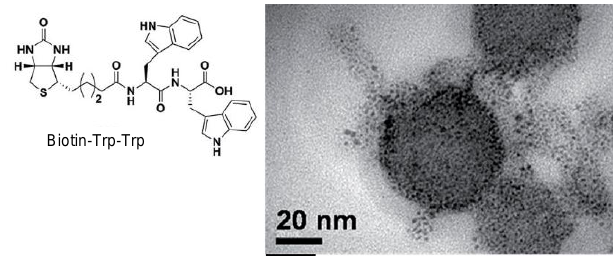
Figure 5. Self-organized AuNPs on the surfaces of biotin-Trp-Trp scaffold.